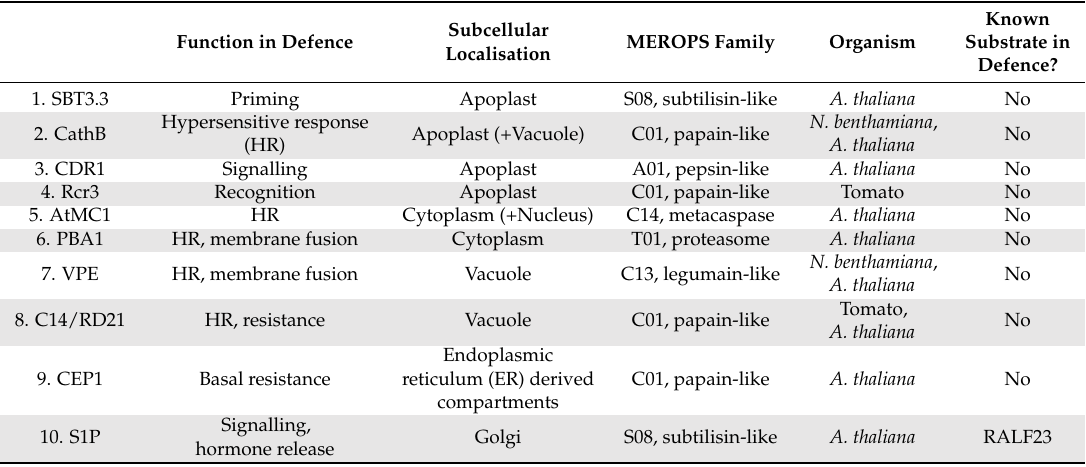
Figure 1. Ten host proteases contributing to the plant defence response. AtMC1, Arabidopsis thaliana metacaspase-1; C14, cysteine protease clone 14; CathB, cathepsin B; CDR1, constitutive disease resistance-1; CEP1, cysteine endopeptidase-1; HR, hypersensitive response; PBA1, proteasome beta subunit-1; PCD, programmed cell death; Rcr3, required for cladosporium resistance-3; RD21, responsive to dessication-21; S1P, site-1-protease; SBT3.3, subtilase 3.3; VPE, vacuolar-processing enzyme. Table 1. Ten prominent host proteases in plant-pathogen interactions.